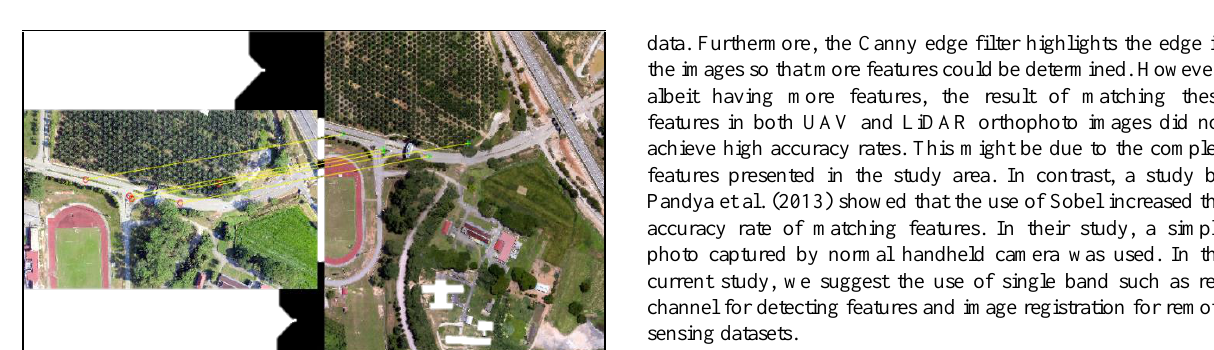
Table 1. Results of the experiments analysed in the current study for selecting optimal case for registration UAV and LiDAR datasets.